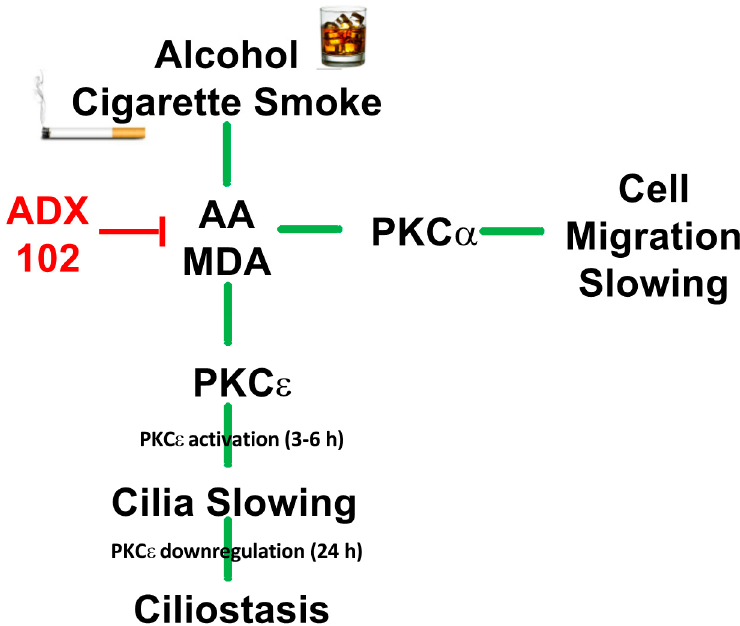
Figure 8. Model diagram for ADX-102 aldehyde-trapping action on cigarette smoke and alcohol mediated injury to airway epithelial cell function.